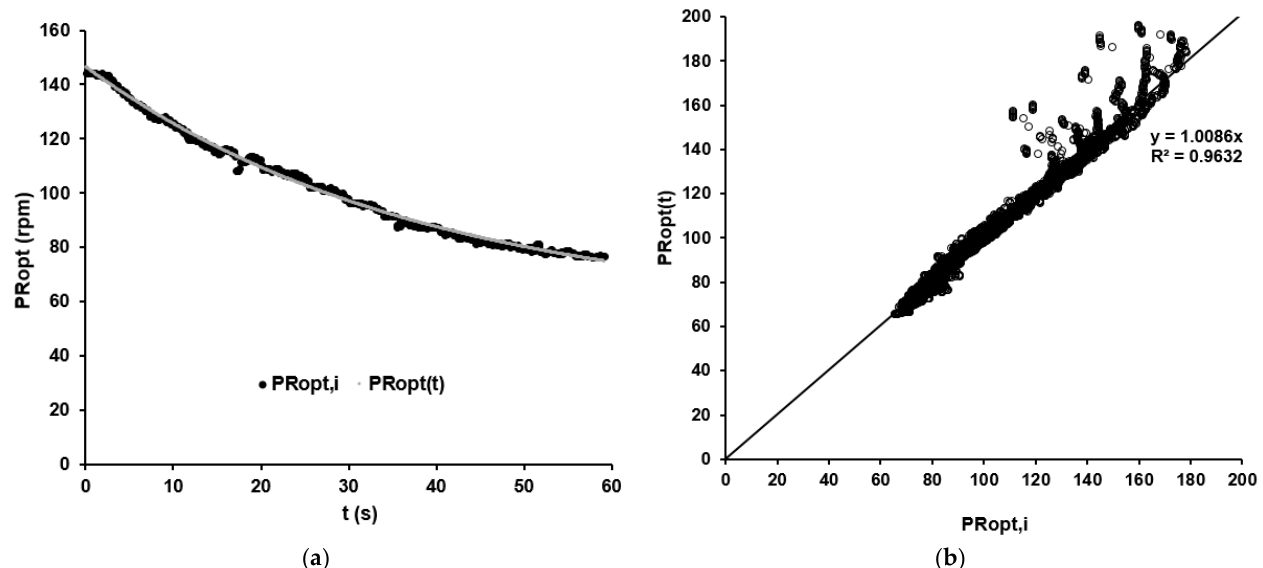
Figure 3. ( a ) The optimal dynamic cadence as a function of time reflects the increase in fatigue with prolonged cycling. Black points: current optimal cadence calculated for data point i (PR opt,i ) calculated using Equation (4). Grey curve: time-dependent optimal cadence (PR opt (t)) calculated using Equation (5). The amplitude A was 85 rpm, the time constant τ was 38.20 s, and the limiting value was c = 55.43 rpm with a time delay of 2.98 s. ( b ) Comparison of measured and modelled data via linear regression analysis.